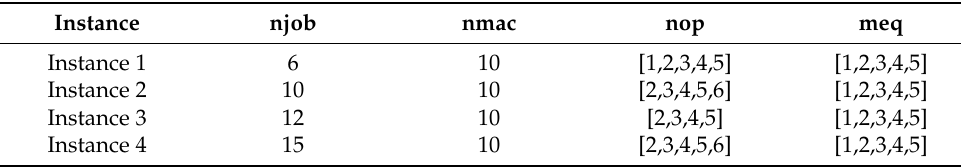
Table 4. The general information of four instances.